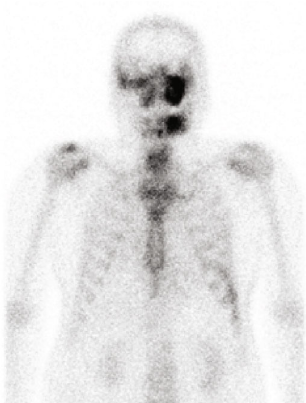
Figure 3: Bone scintigraphy fi ndings obtained during the initial visit. Bone scintigraphy shows an accumulation of technetium medronic acid in the right skull base, cervical spine, left maxilla, and left mandible.